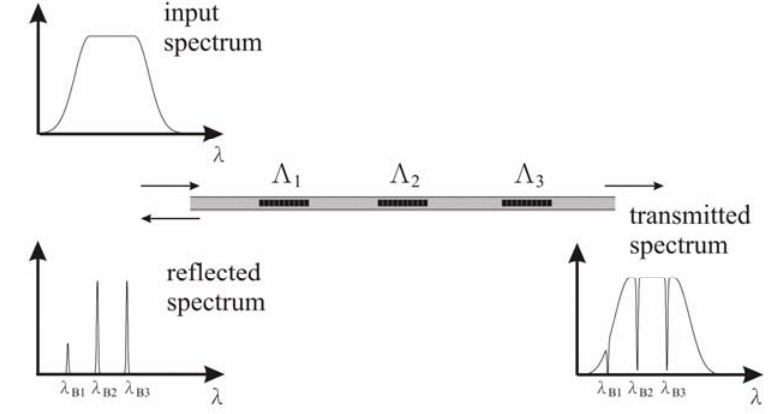
Figure 3. Principle of multiplexing of serial FBG sensors. A sequence of separated